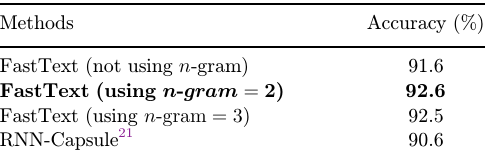
Table 4. Experimental results on Amazon